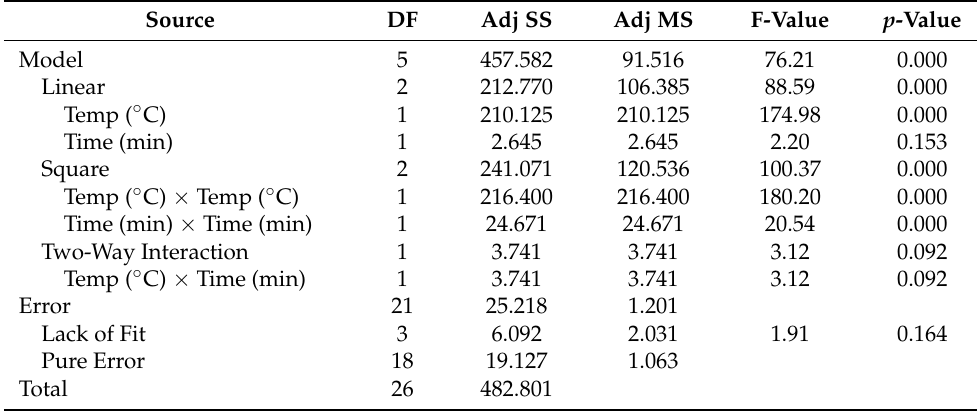
Table 4. Analysis of variance for cellulose